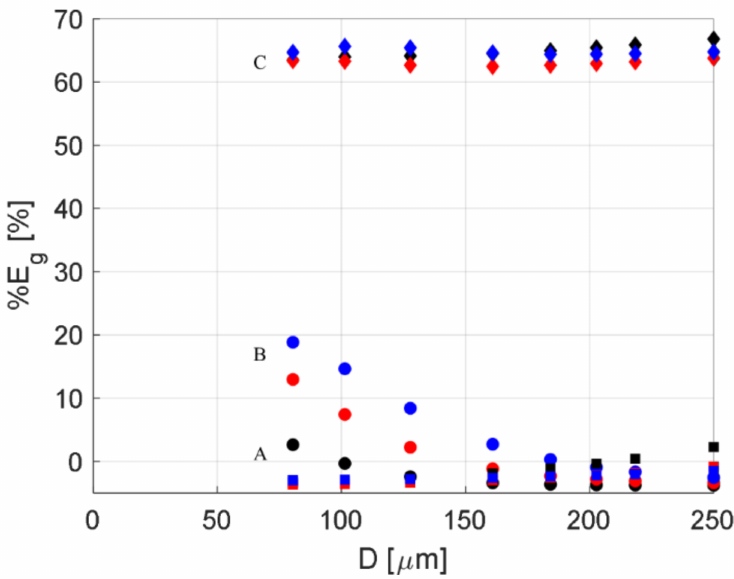
Figure 9. Relative error %E g between set local breakup frequency and estimated global breakup frequency as a function of drop diameter, D . Results are showed for the three cases: A (squares), B (disks) and C (diamonds) in Figure 6 and for three different flow conditions: U g = 1.5 m/s ( black ), U g = 3.0 m/s ( red ) and U g = 6.0 m/s ( blue